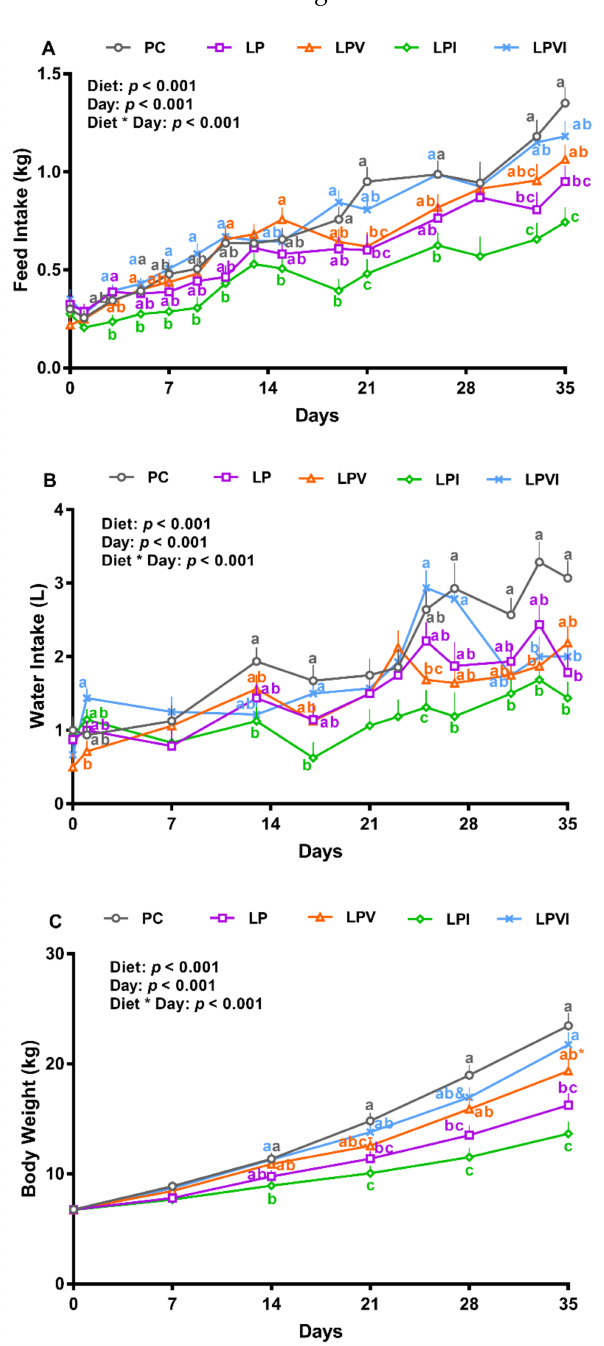
Figure 1. ( A ) Feed intake, ( B ) water intake, and ( C ) body weight of nursery pigs fed with very-low- protein diets supplemented with Ile, Val, or combination of both. PC (positive control): standard- protein diet; LP (negative control): low-protein diet containing limiting amino acids (i.e., Lys, Met, Thr and Trp) at NRC (2012) levels; LPV: LP containing Val at NRC level; LPI: LP containing Ile at NRC level; LPVI: LP containing Val and Ile at NRC levels. The values are means ± standard error of the mean. n = 8. a,b,c Among groups, the means with different superscript letter(s) are different ( p ≤ 0.05). & p ≤ 0.1 LPVI vs. LP, * p ≤ 0.1 LPV vs.